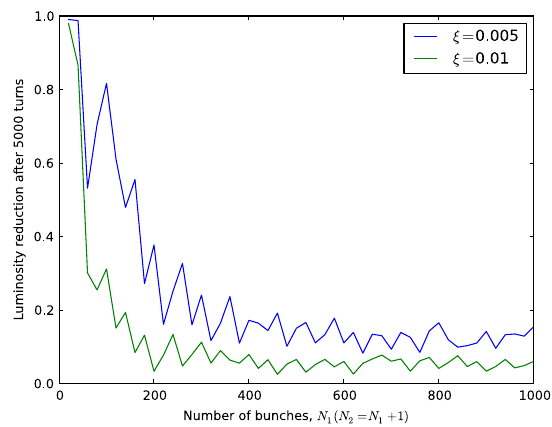
FIG. 6. Luminosity reduction as function of the bunch number N 1